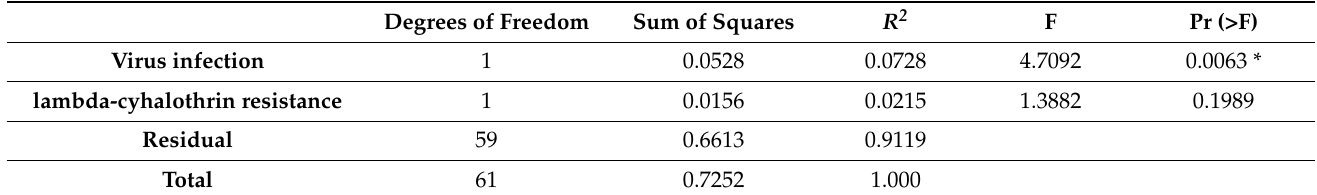
Table 3. Permutational multivariate analysis of variance test (adonis2 function) of midgut bacteria from Ae. aegypti populations with different ZIKV infection and lambda–cyhalothrin resistance statuses (* p < 0.05).